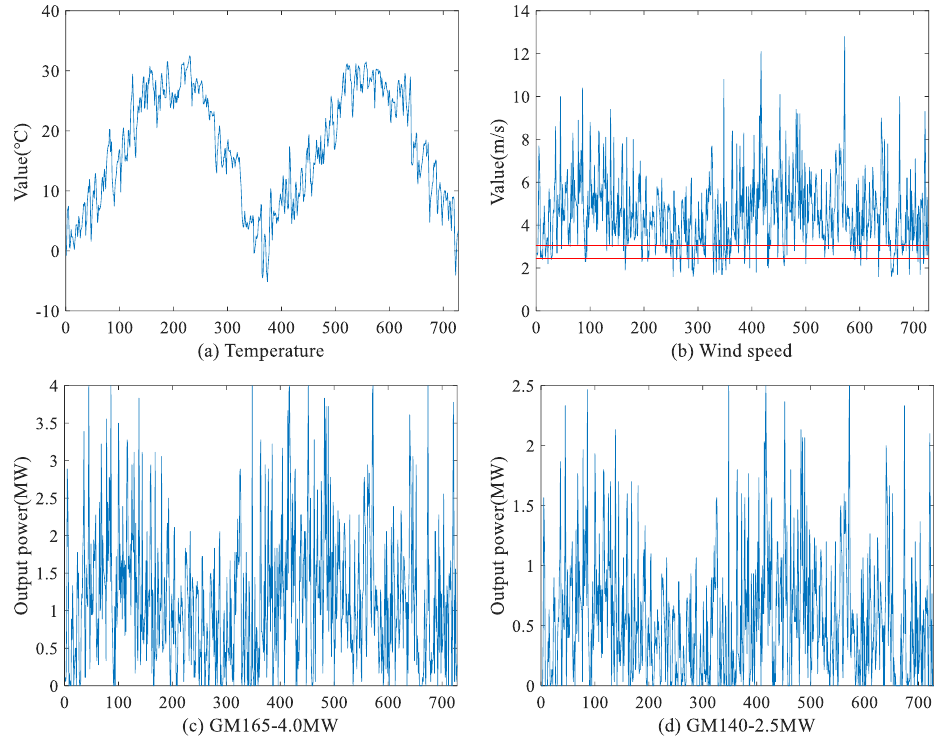
Figure 5. The changes in wind speed, temperature, and power in the wind farm. The coordinates of 18 turbines for demonstration are shown in Table 5. The interval distance between turbines will affect their output power and power generation. The closer the distance, the stronger the influence, which is called the wake effect. The farther the distance, the less conducive for repairmen to implement maintenance behaviors. There- fore, this paper sets the interval between two turbines as [100, 3600] to reduce the wake effect and conform to the real wind farm. Assume that the x coordinate range of turbines is [1000, 5000], and the y coordinate range is [550, 3000]. In addition, assume that the wake effect has no effect on the output power of turbines. Table 5. The coordinates of 18 turbines. Number of Turbines (3918, 2179) According to the turbine components’ parameters in [32,35], the random generation functions of Weibull parameters are set and finally shown in Table 6. According to the parameters of components, the state transition probability of the turbine components is obtained. The probability of turbine components in different states is shown in Figure 6. The sum of probabilities in different states is 1.